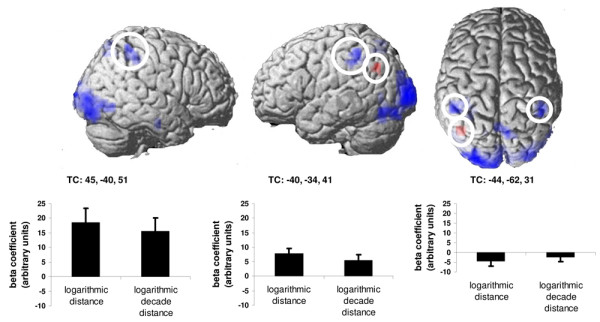
Voxels showing stronger activation for the overall distance than for decade distance are coloured blue while voxels showing stronger activation for the decade distance than for overall distance are coloured red (p < .001, uncorrected, k = 10 voxels). While overall distance activated large portions of the anterior intraparietal cortex bilaterally in comparison with decade distance only, as well as in the extrastriate cortex, decade distance only deactivated voxels in the left angular gyrus relative to overall distance. ROI analyses revealed stronger activation in the intraparietal cortex bilaterally in response to overall distance compared to decade distance as well as a slight deactivation in the left angular gyrus.